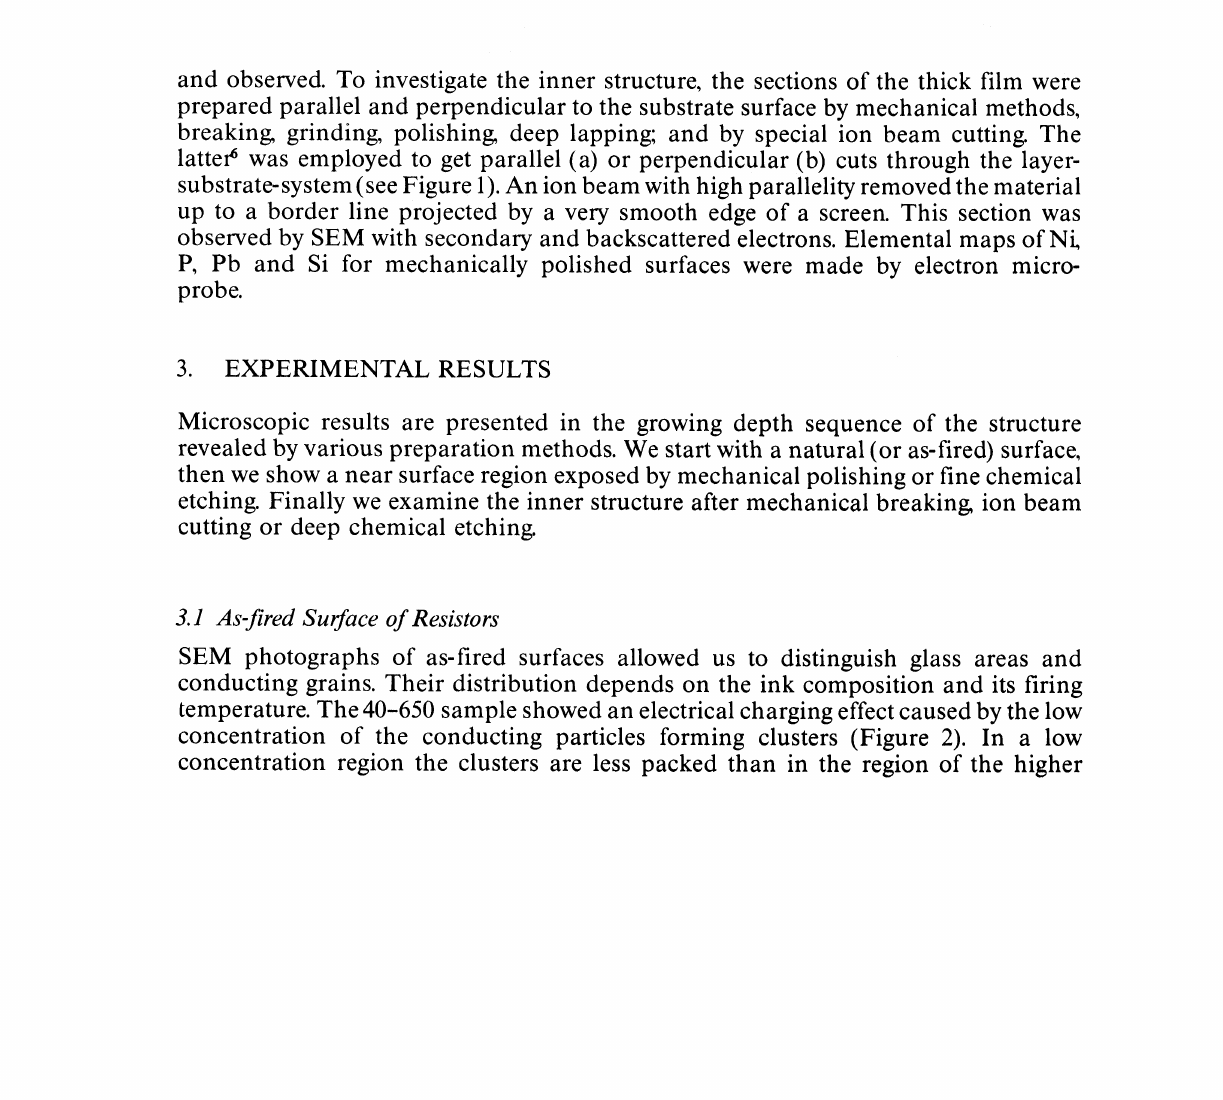
FIGURE Ion beam cutting method, a) cut parallel to the substrate surface, b) cut perpendicular to the substrate surface: IB ion beam, E screen edge, L- thick film layer, S substrate, A- cut area, R- bombarded